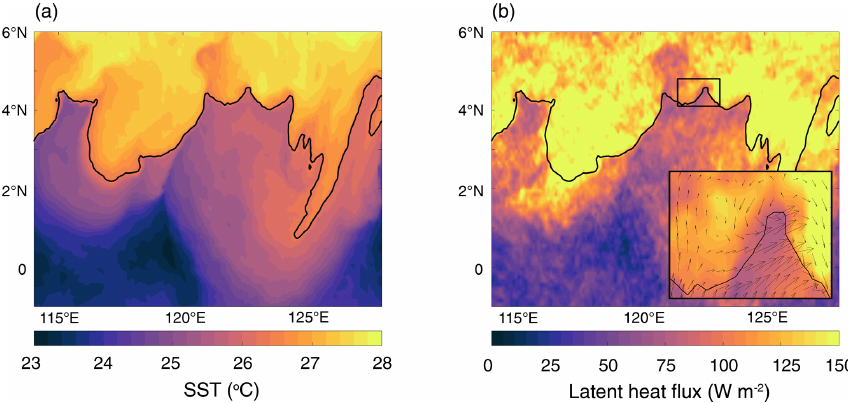
Figure 13. Breaking of a tropical instability wave in the Pacific in G_AO_2.5km with (a) SST and (b) latent heat flux. The black line shows the 26.3 ◦ C isoline. Snapshot for 5 February 2020 at 23:00. The inset in (b) shows a blow-up of the region enclosed by the rectangle at about 4 ◦ N and 122 ◦ E.